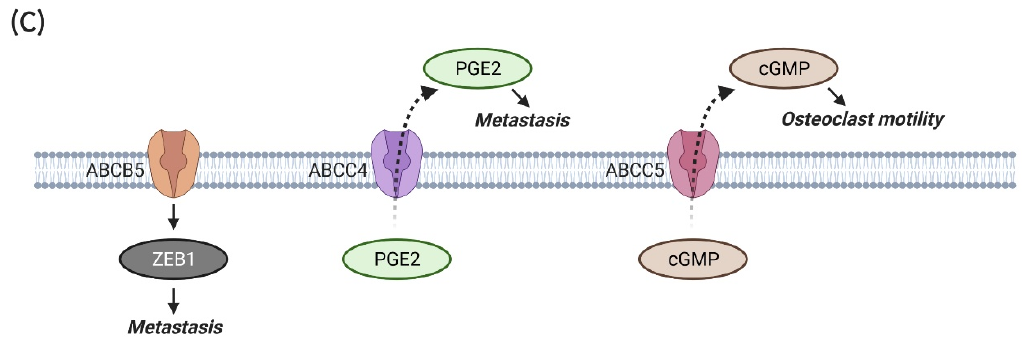
Figure 5. The role of ABC transporters in breast cancer metastasis. ( A ) The ABCB1–CD44 interaction leads to the activation of extracellular signal-regulated protein kinase 1/2 (ERK1/2) and p38 mitogen-activated protein kinases (MAPK), which increase metalloproteinase (MMP) at a transcriptional level and proteolytic activity and, thus, invasive behaviour [111,120]. The binding of hyaluronan to CD44 further promotes ABCB1 expression and activity via ankyrin–cytoskeleton interactions, Nanog-Stat-3 signalling, ErbB2 signalling and the phosphatidylinositol 3-kinase/protein kinase B (PI3K/AKT)-related survival pathways [121]. ( B ) ABCB1 coupled with its substrate drug, vinblastine (VBL), or trans-flupentixol ( t FPT), enhances the PI3K activity, which triggers membrane ruffling, an early indicator of cellular motility and metastatic potential in cancer cells [122]. ( C ) ABCB5, ABCC4 and ABCC5 regulate breast cancer metastasis via the downstream effector Zinc finger E-box-binding homeobox 1 (ZEB1) [123], the export of an inflammatory mediator prostaglandin E 2 (PGE2) [99,124] and the efflux of cyclic guanosine monophosphate (cGMP) [125], respectively. Figures were created with BioRender.com (accessed on 22 March